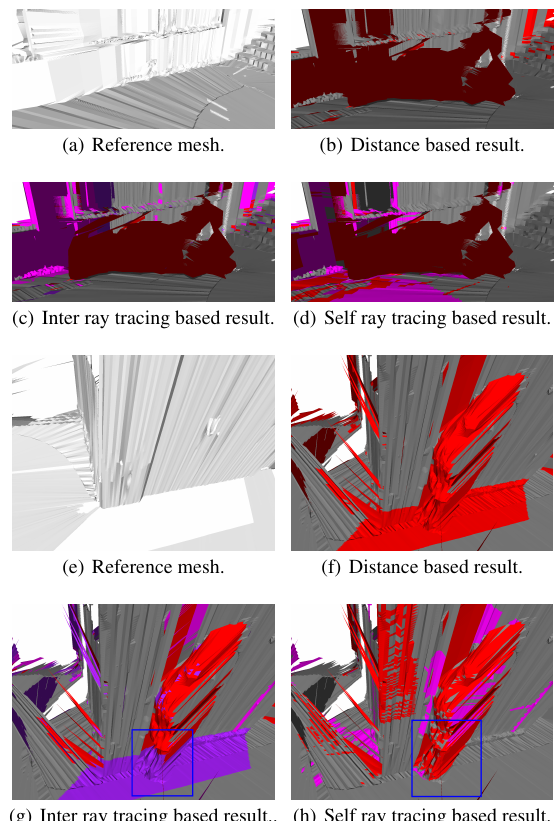
(a) Reference mesh. (b) Distance based result.